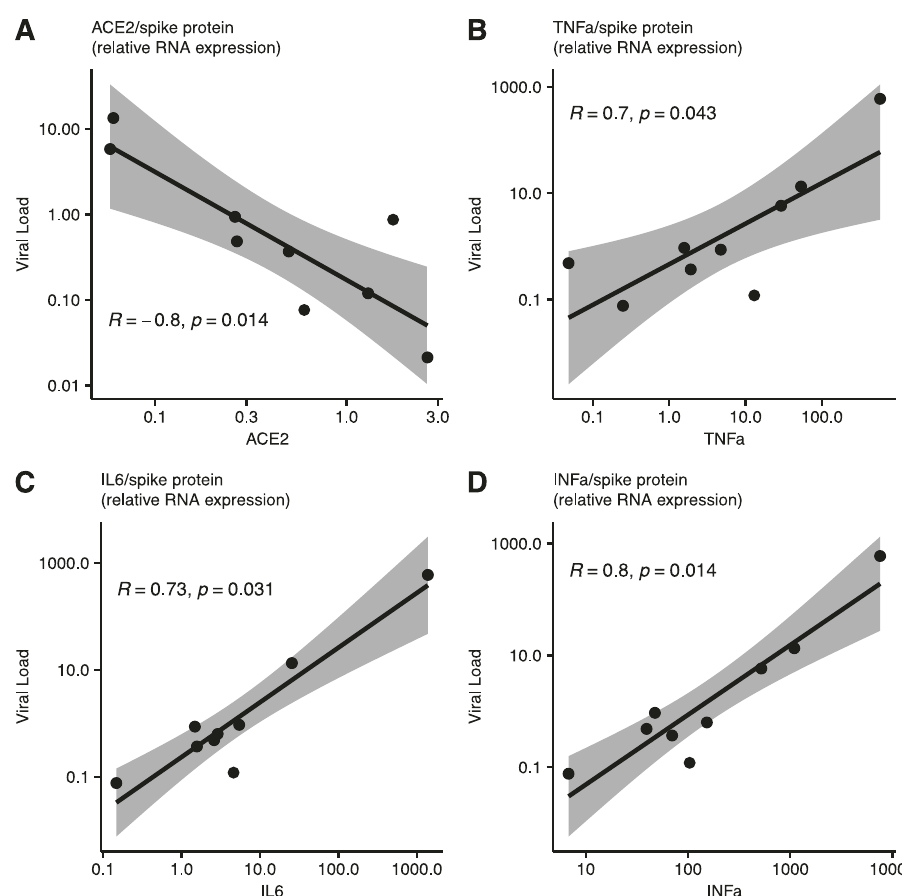
Fig. 4 Cardiac ACE2 and cytokine expression levels correlate with cardiac viral load. A Increased SARS-CoV-2 spike protein RNA expression is signi fi cantly correlated with reduced gene expression levels of ACE2 and increased cytokine expression levels of B TNFa, C IL6, and D IFNa (Spearman ’ s rank correlation, regression slopes are represented by black lines, grey area represents 95% CI, n = 9).